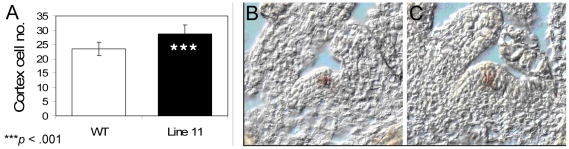
Comparison of WT and RNAi Line 11 root and shoot apical meristems.(A) t-test comparing WT with RNAi Line 11 cortex cell number in meristematic zone of root apex 6 DAS. P<0.001 (n = 33); (B) in situ analysis of CLV3 expression in Arabidopsis vegetative SAMs at 9 days post germination.